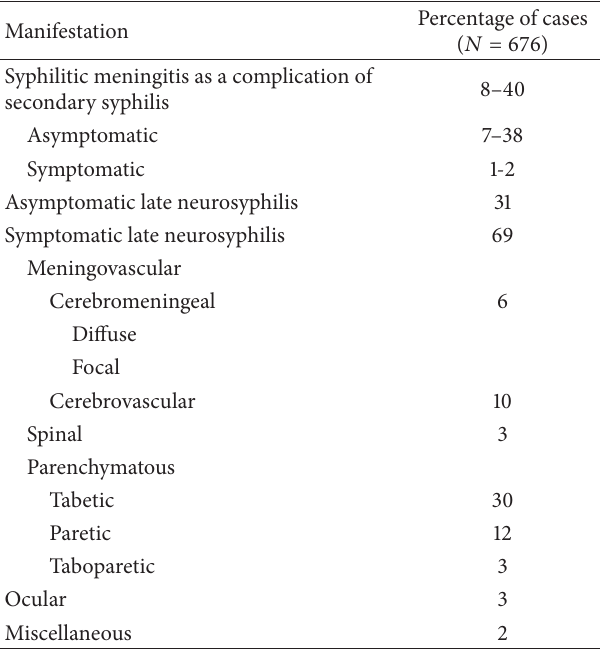
Table 1: Classifications of neurosyphilis